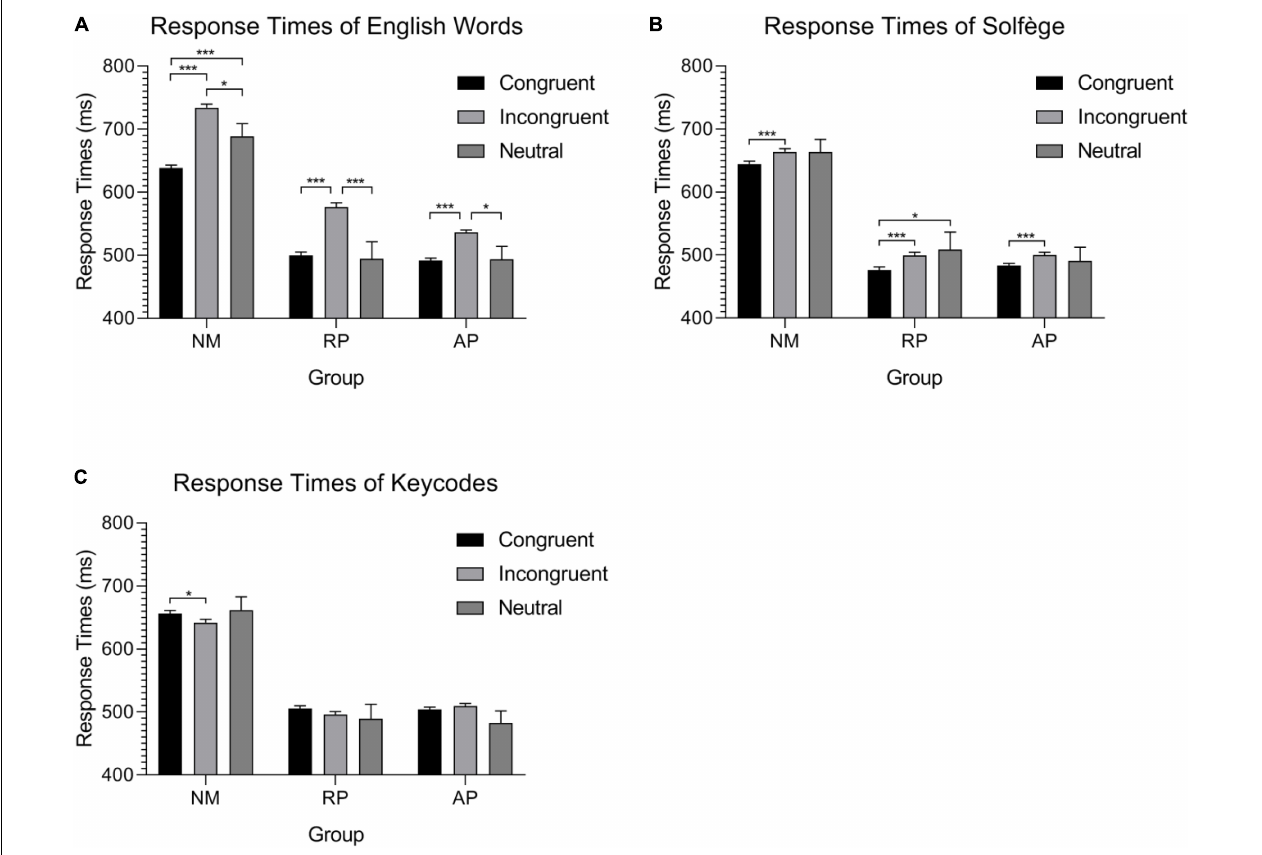
FIGURE 1 | Group mean response time during the three auditory Stroop tasks. (A) Musicians and non-musicians process neutral stimuli differently during the English words task. (B) Significant differences between congruent and incongruent stimuli in the solfège task show a possible facilitation effect of the lexicon but still demonstrate interference. (C) A possible reverse behavioral Stroop effect for alpha-numeric codes is found for isolated alpha-numeric codes from color-words in NMs, though the effect is marginal. No other differences are found for this task. ∗ p < 0.05, ∗∗ p < 0.01, and ∗∗∗ p <